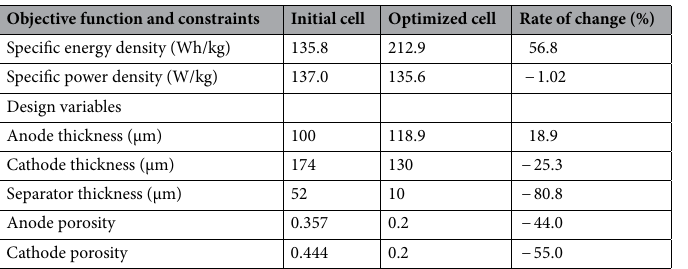
Objective function and